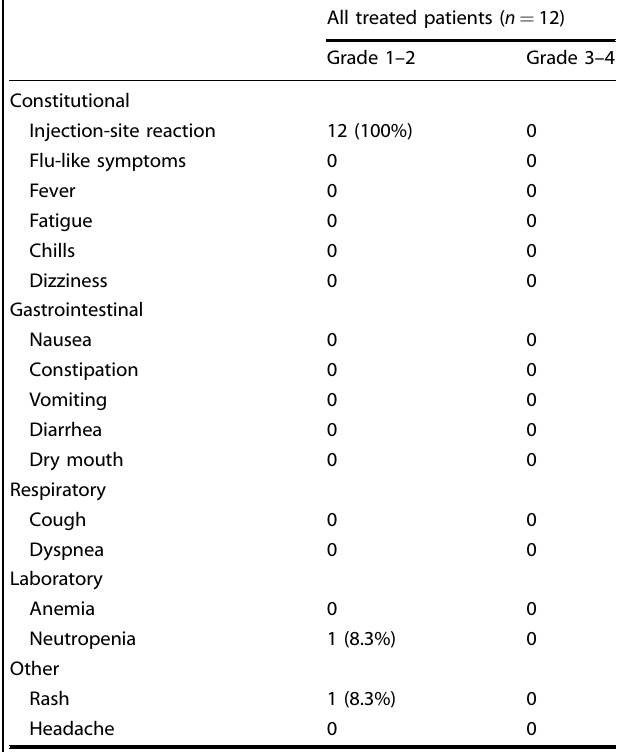
from such therapy. After combining ICIs treatment with Neo- Table 2. Treatment-related adverse events in all treated patients a DCVac, all these patients achieved disease control (2 PRs and 2 SDs), and tumor sizes were reduced by up to 80% (Fig. 2d, All treated patients ( n = 12) Supplementary Table 2). According to the clinical report, three of